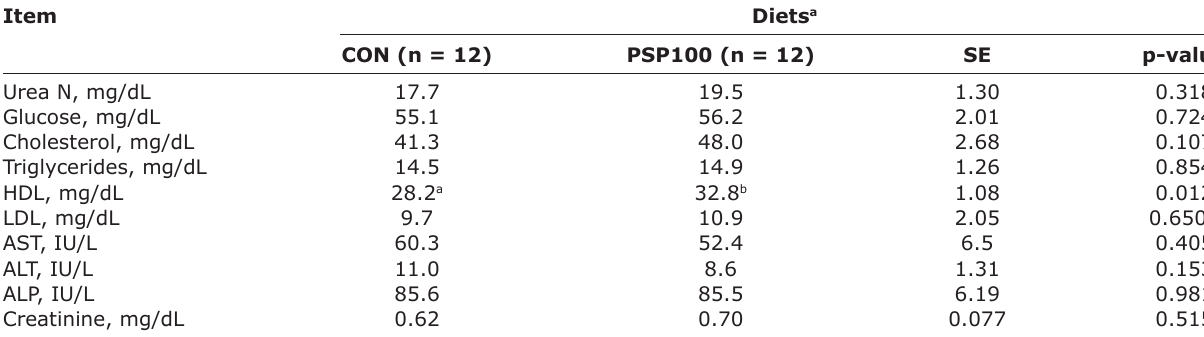
Table-6: Effects of feeding PSP on blood parameters of Awassi lambs.